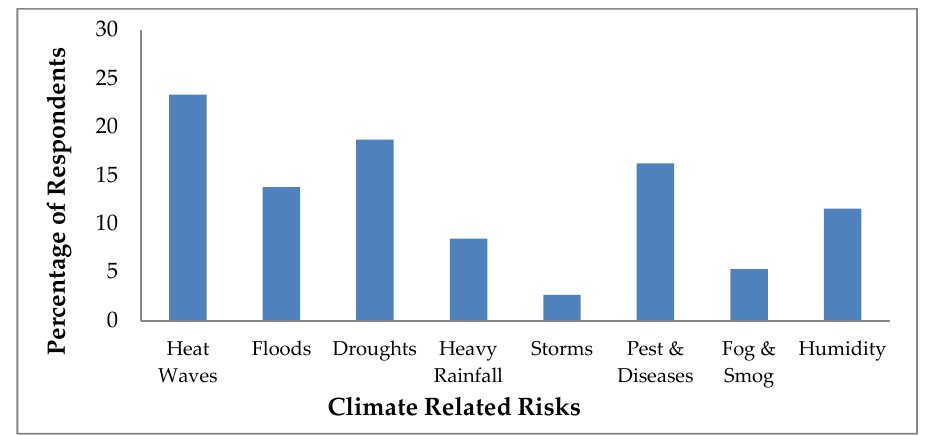
Figure 4. Climate-Related risks perceived by the dairy farmers.